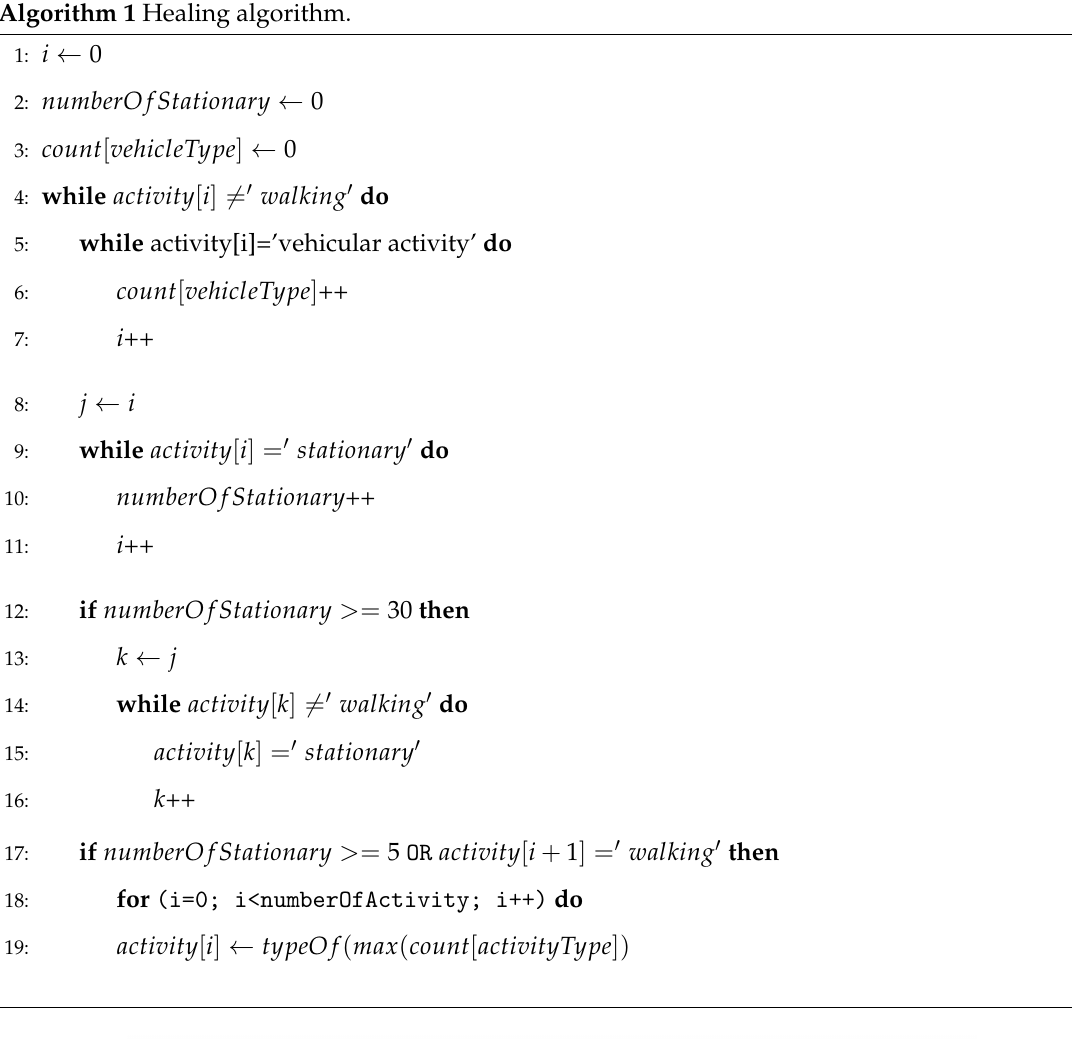
Algorithm 1 Healing algorithm.